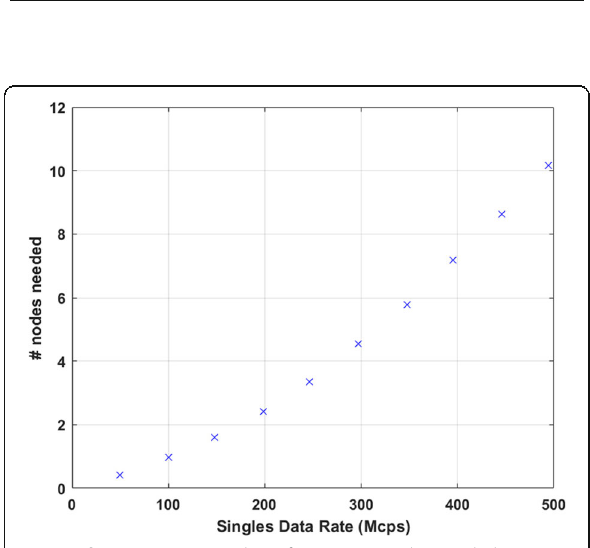
Fig. 2 (abstract A12). Number of computer nodes needed to achieve near real-time coincidence processing performance